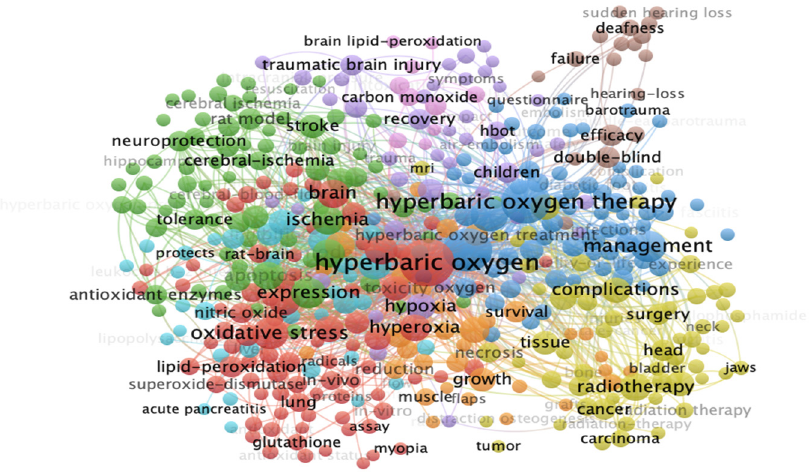
Figure 9. Network visualization of keyword co-occurrence.